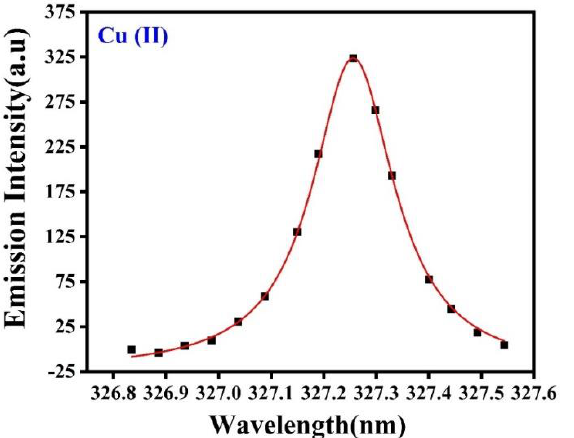
Figure 6. A Lorentzian fit of 327.26 nm line used for calculation of electron number density of Cu-plasma.